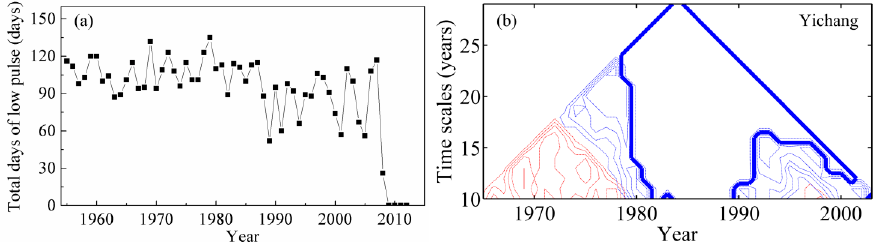
Figure 7. Changes in total days of low pulses at the Yichang station: ( a ) annual values; ( b ) abrupt behaviors.